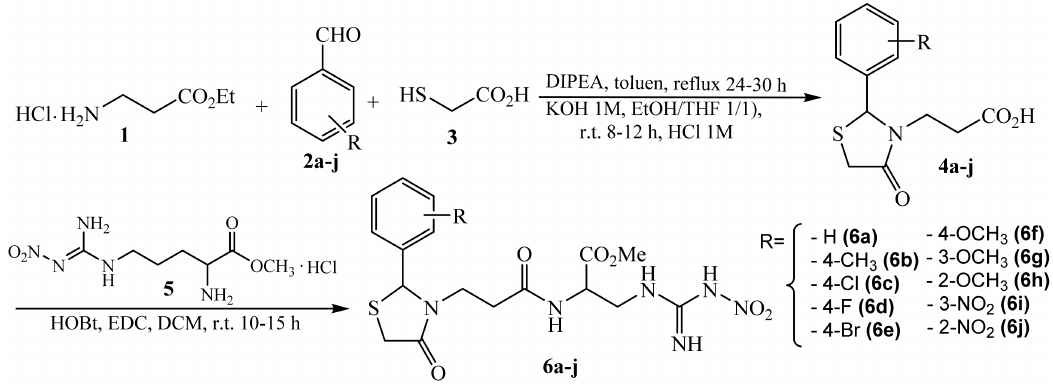
Figure 1. The synthesis of arginine derivatives with thiazolidine-4-one scaffold (ArgD: 6a – j